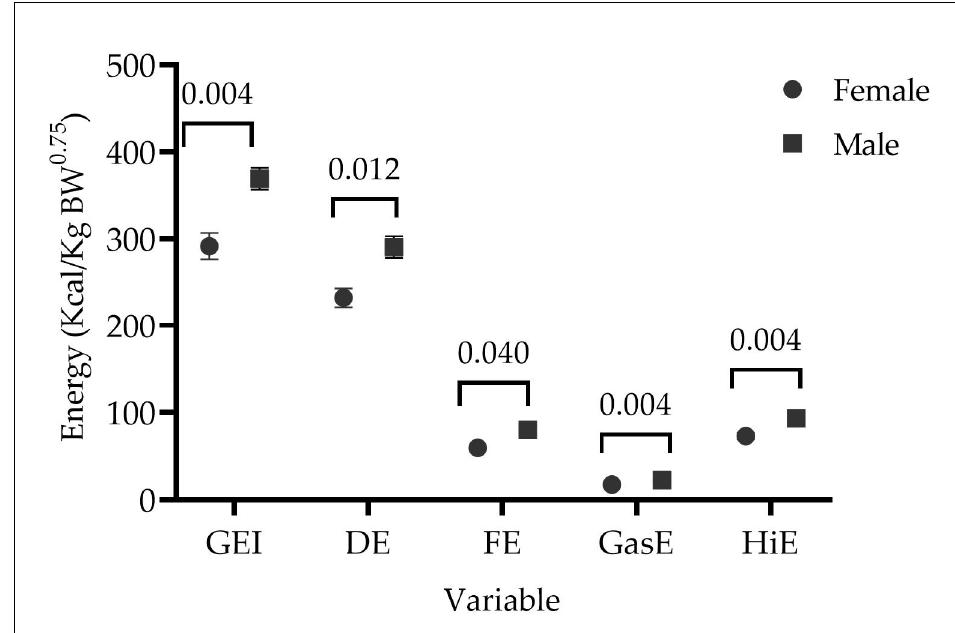
Figure 5. Effect of sex on GEI (gross energy intake), DE (digestible energy), FE (faecal energy), GasE (combustible gas energy) and HiE (heat increment energy) of females and males fed unflavoured diet or diet flavoured with sucram, capsicum or both. Data are expressed as the mean ± standard error.